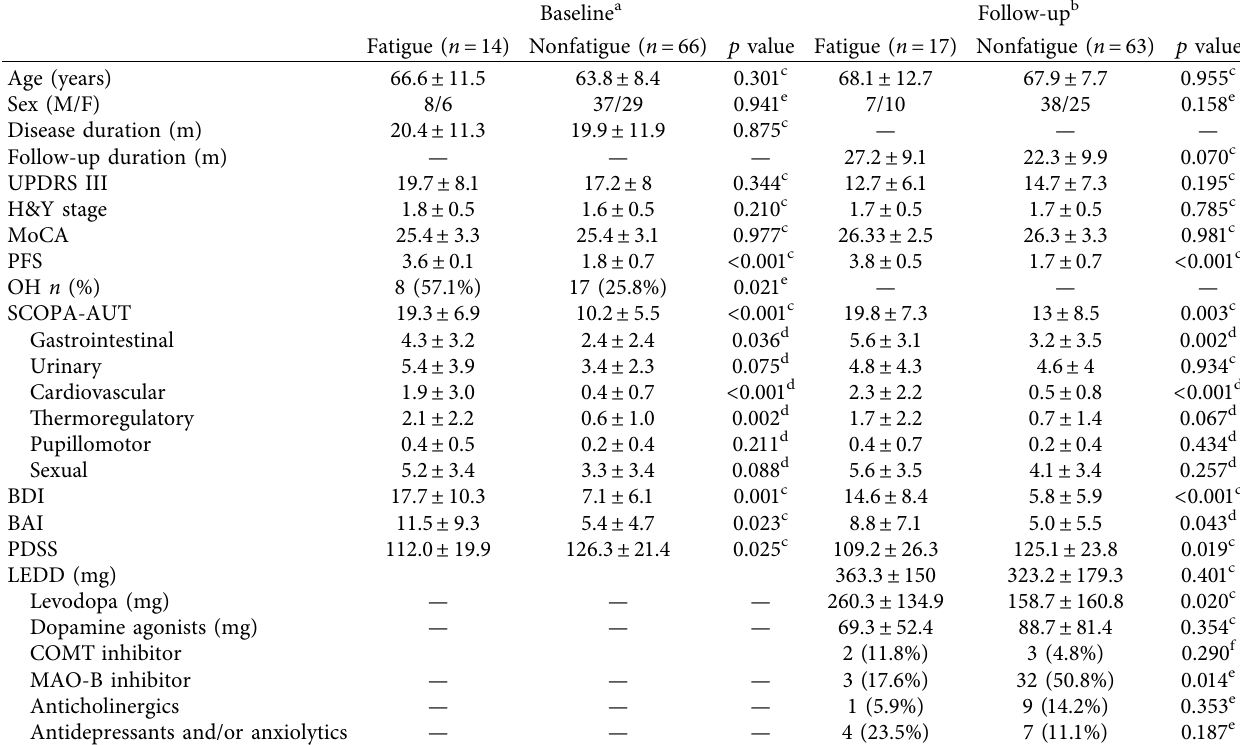
Table 1: Baseline and follow-up demographics and clinical characteristics of fatigue and nonfatigue